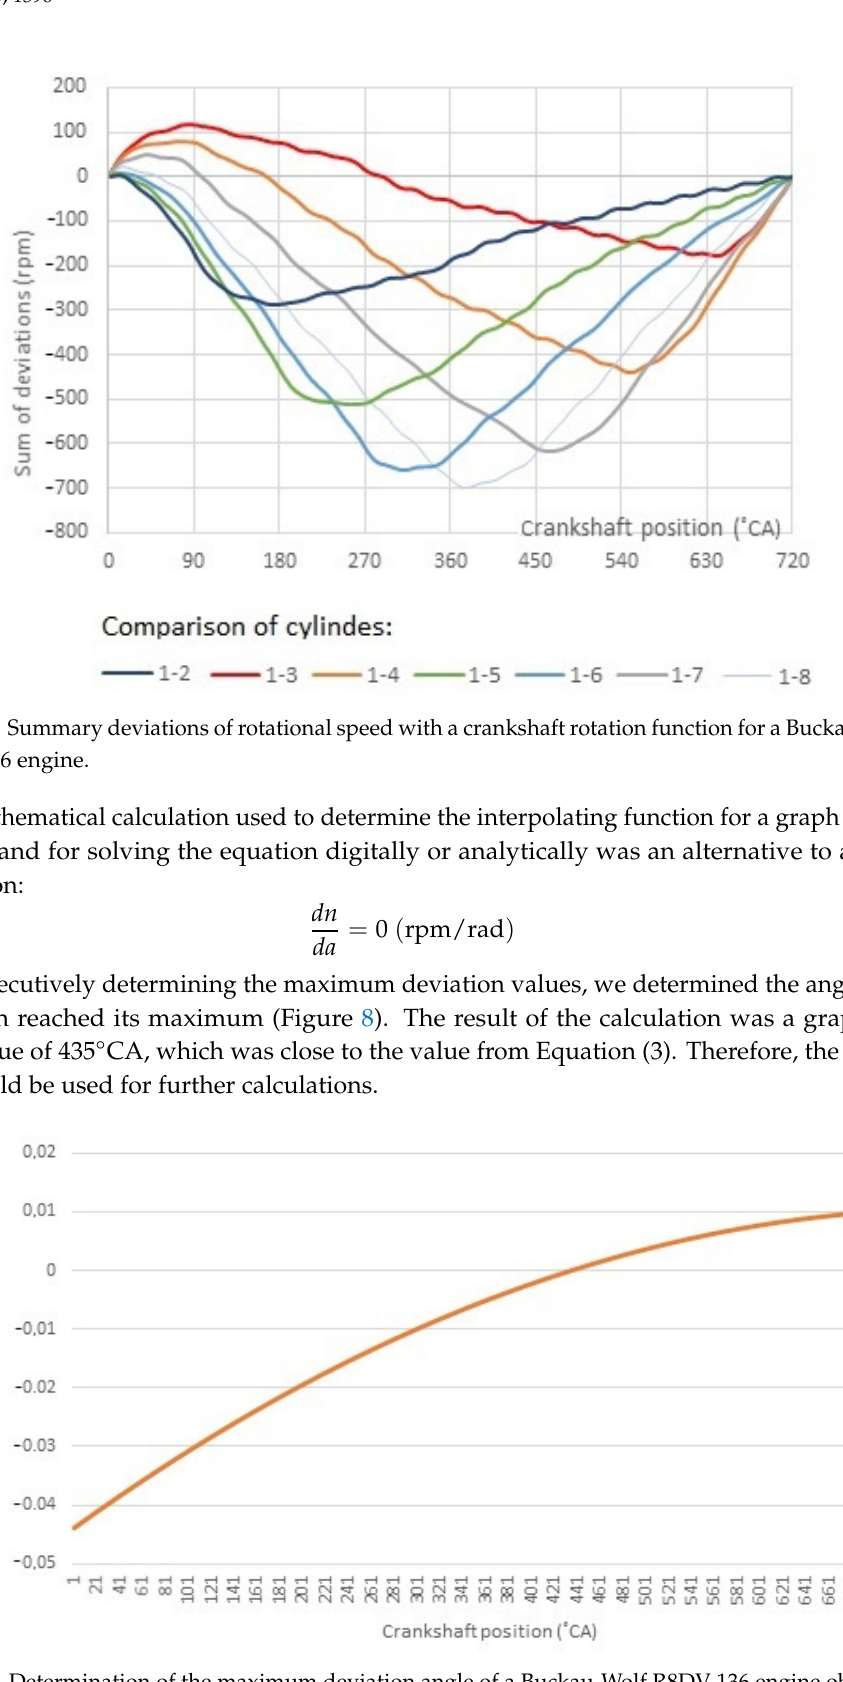
Figure 8. Determination of the maximum deviation angle of a Buckau-Wolf R8DV-136 engine obtained by a differential equation.